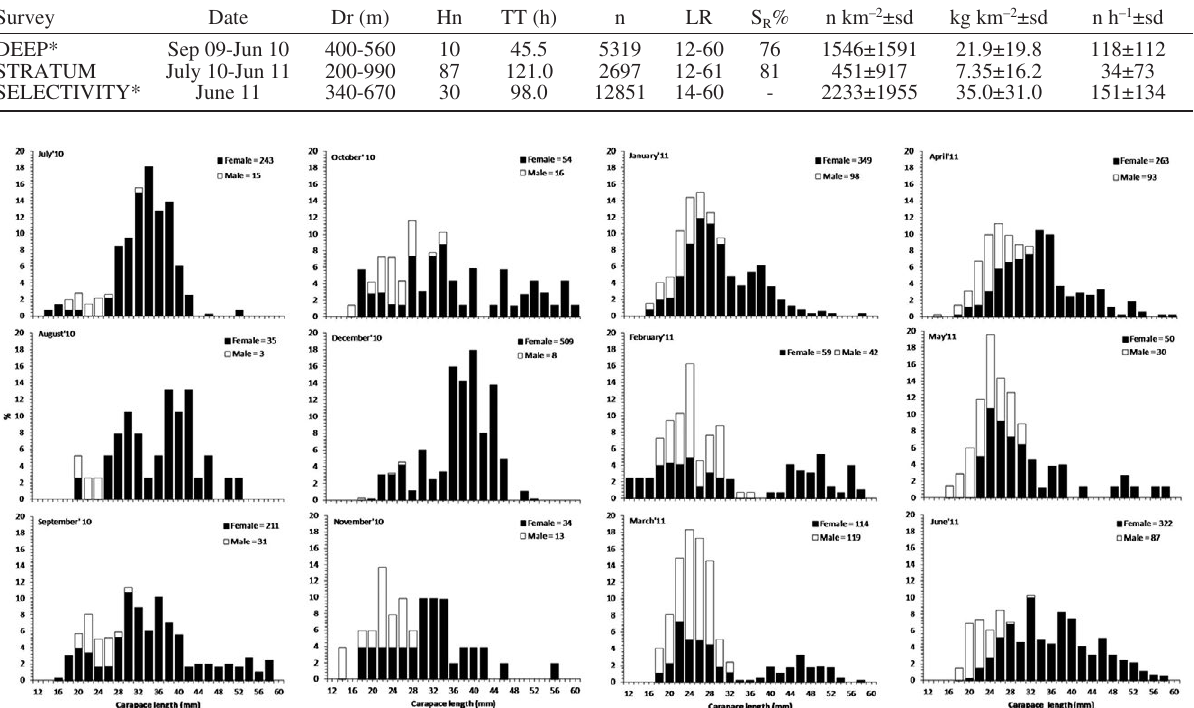
males.Table 1. – Abundance, biomass, catch per unit effort and haul characteristics of the three trawl surveys in Antalya Bay. Dr, depth range; Hn, , sex ratio; *, surveys carried number of hauls; TT, trawling time; LR, min-max length range of carapace; n, number of specimens caught; S R out only in the commercial fishing area.